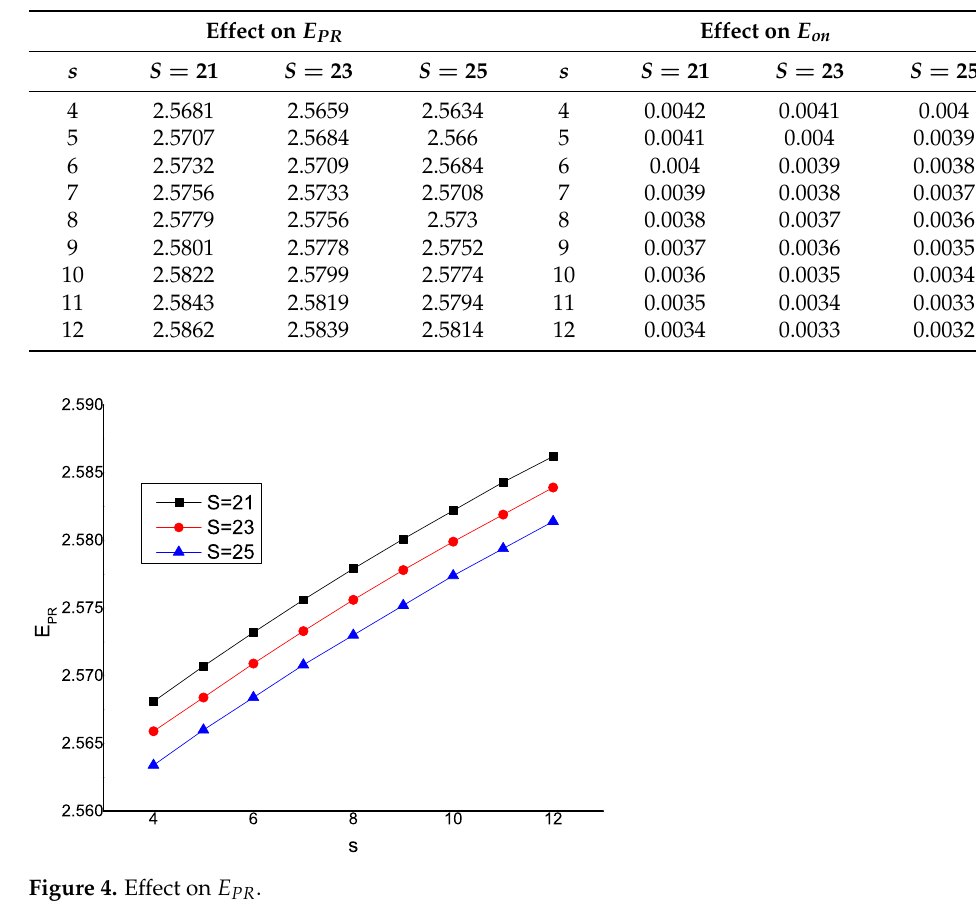
Table 6. Effect of s and S for ( c , δ , λ , µ , η ) = ( 3,0.8,4,7,2.6 ) .